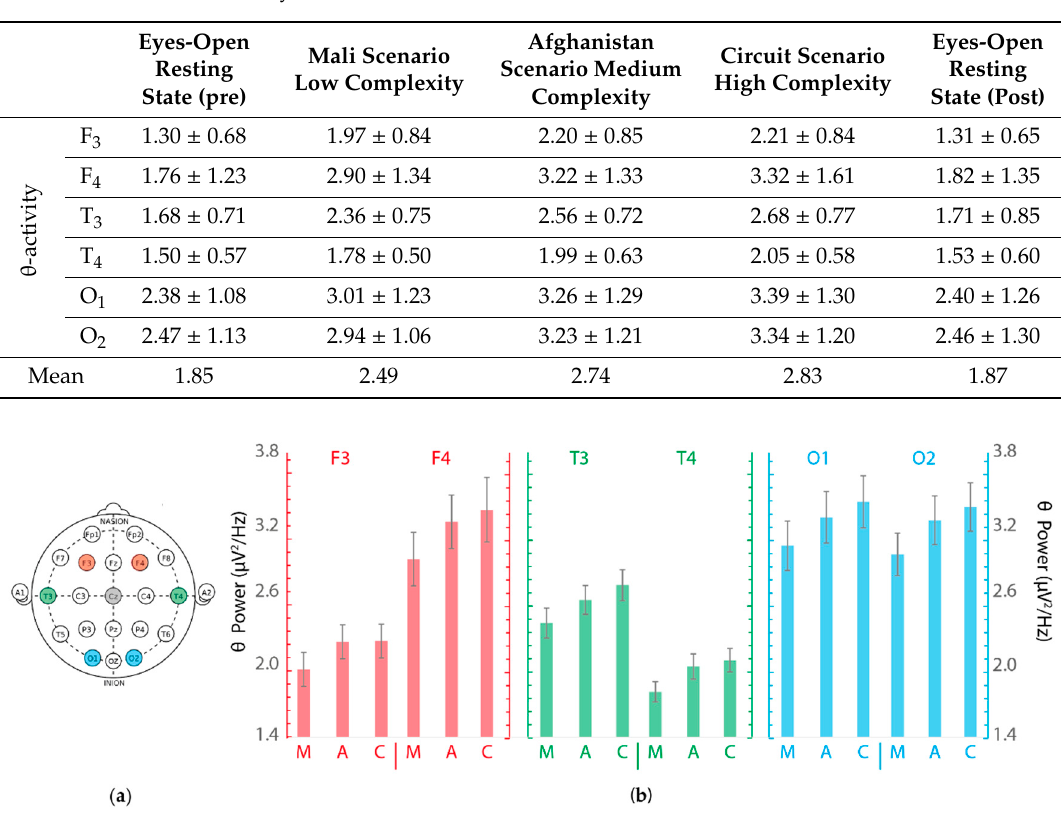
Figure 2. ( a ) Electroencephalographic (EEG) recording configuration. Red elements represent the frontal channels (F3 and F4), the green ones represent the temporal channels (T3 and T4), and the blue ones represent the occipital channels (O1 and O2). CZ was used as a reference. ( b ) EEG theta power (µV 2 /Hz) per channel for each simulated scenario ( n = 35). M: Mali, low complexity; A: Afghanistan, medium complexity; C: Outdoor test course circuit, high complexity. Error bars represent the SEM across participants. There were significant main effects of terrain complexity and channel (all p -values < 0.05).